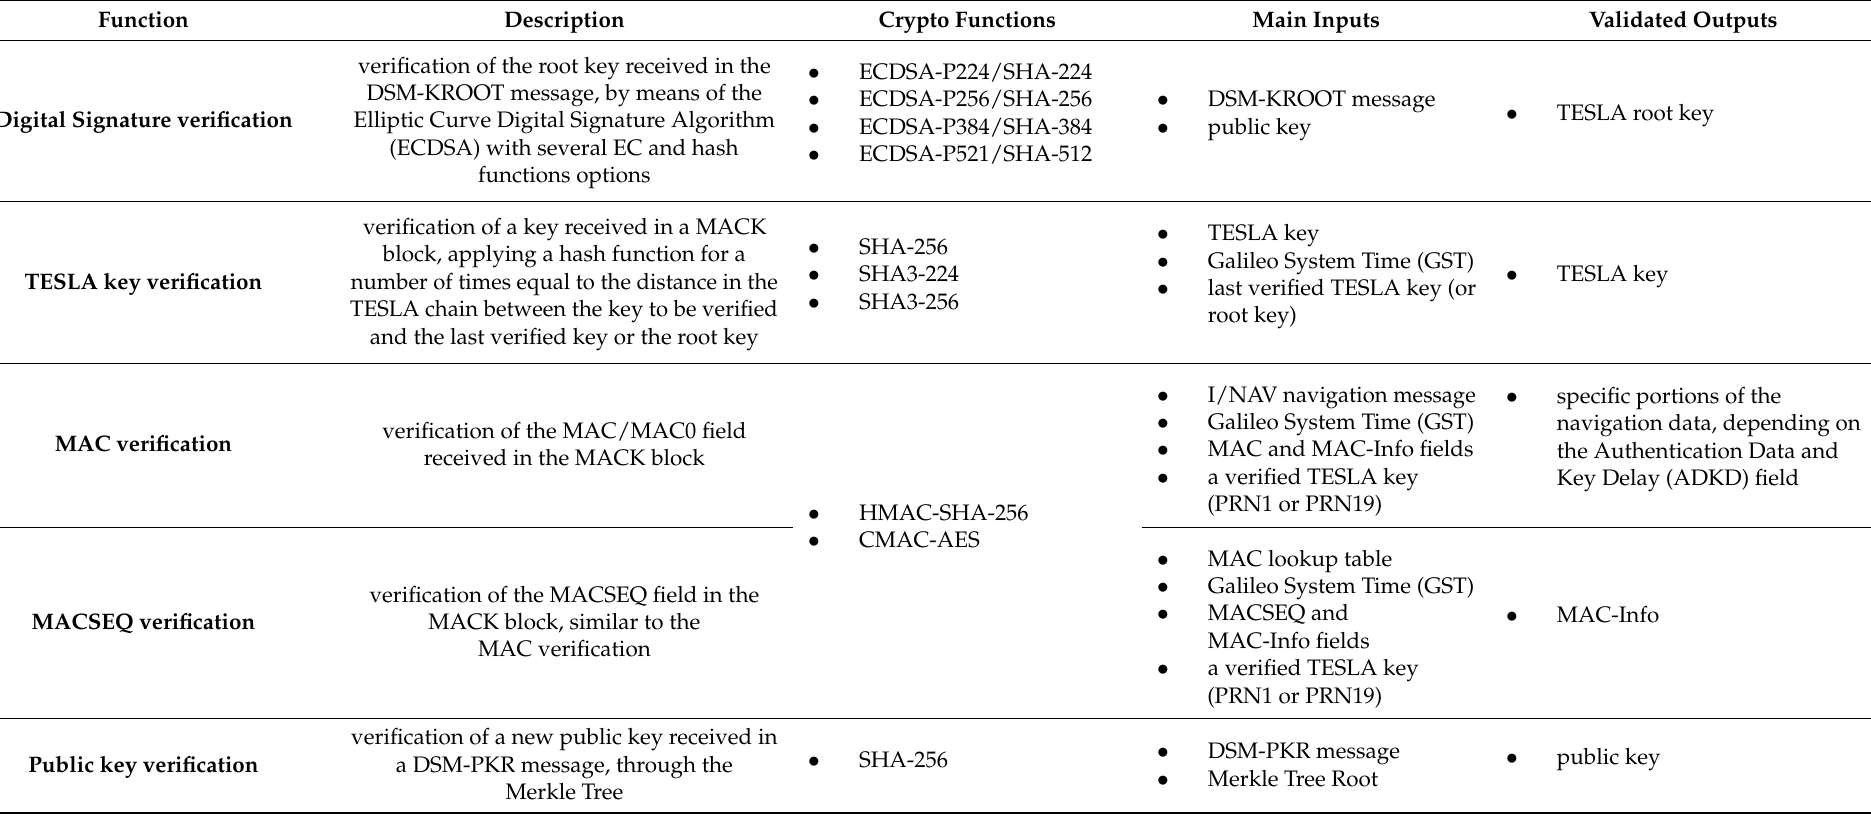
Table 1. OSNMA functions’ descriptions. For each one the list of cryptographic functions, main inputs and outputs are also shown. © [2020] IEEE. Reprinted, with permission, from [16].